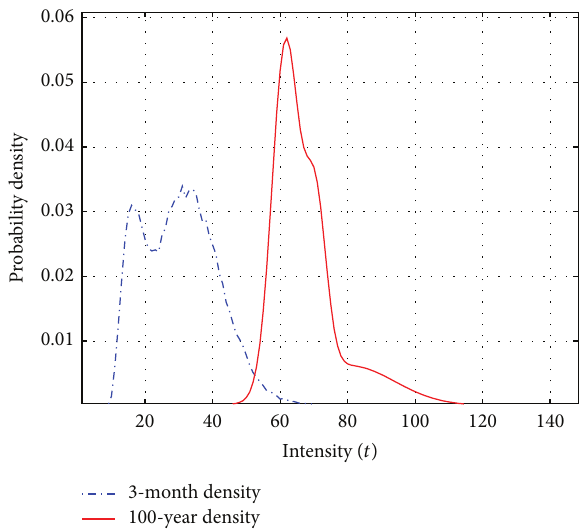
Figure 20: Maximum value distribution of the truck loads during the reference design